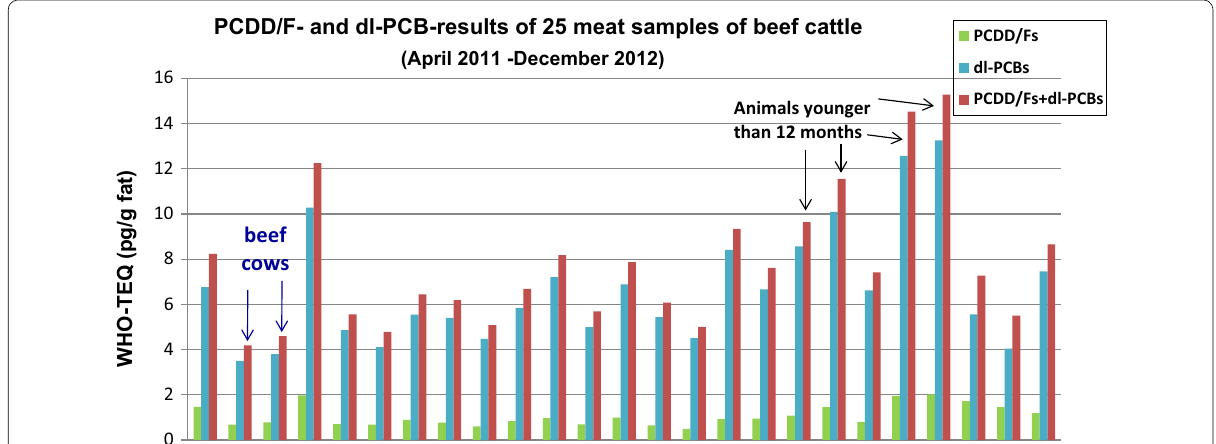
Fig. 3 PCDD/F and dl-PCB TEQ levels in meat of beef cattle on a pasture with elevated PCB–soil levels (mean 2 ng WHO-PCB-TEQ/kg dm, range